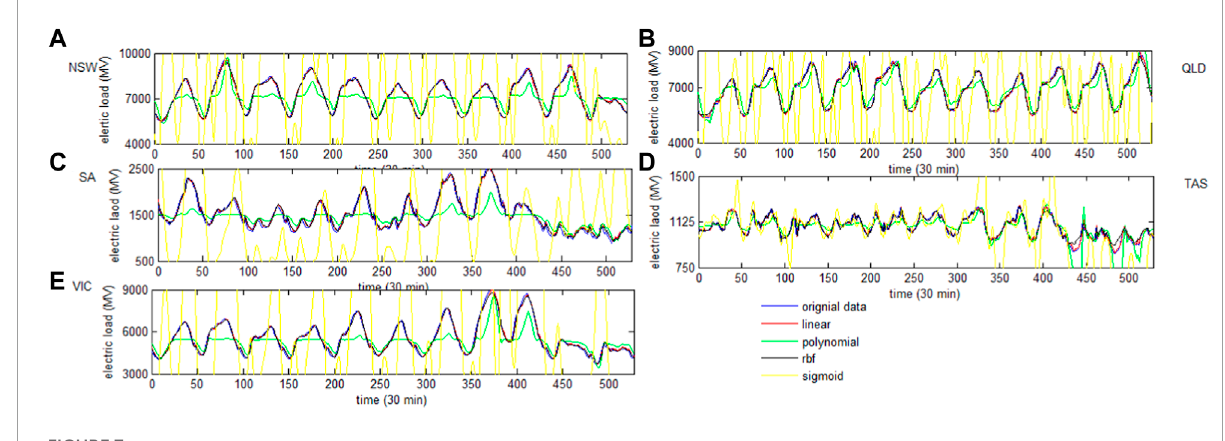
FIGURE 7 Predictive results of the SVR with different kernel functions.